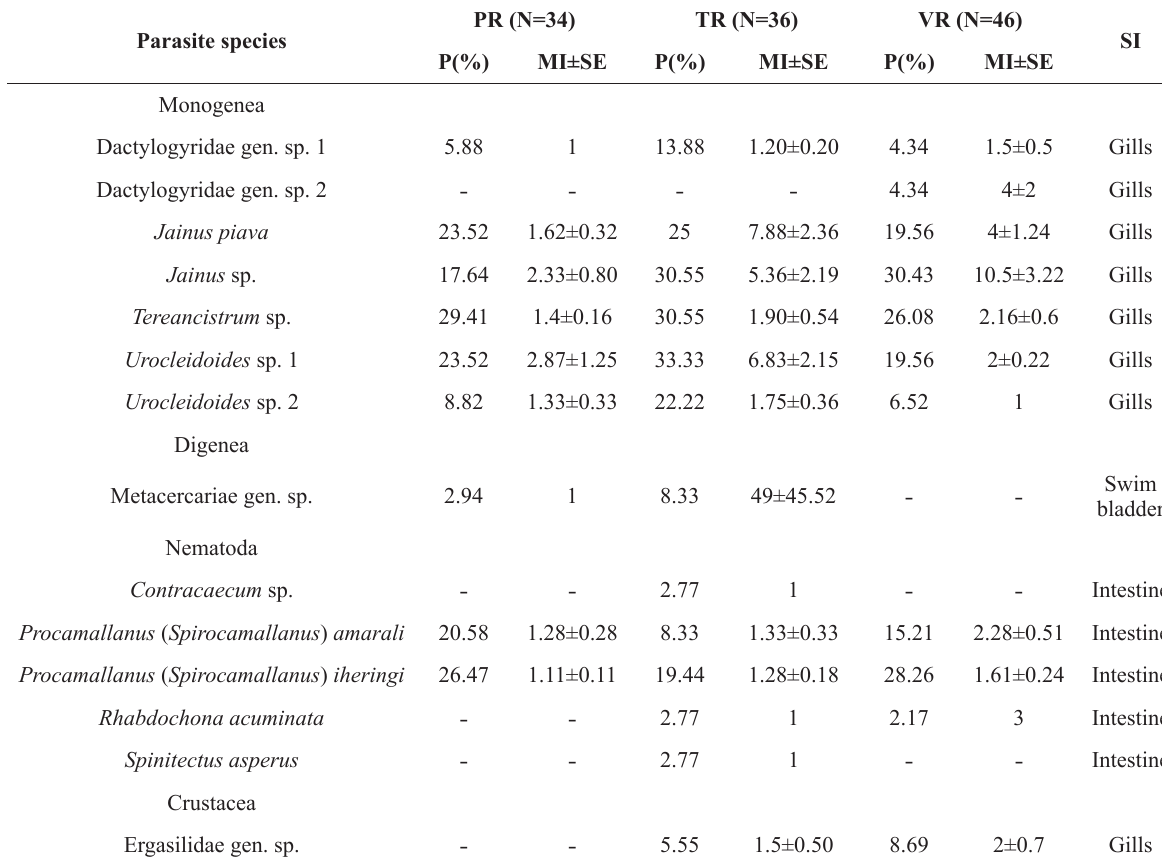
Parasite component community of Leporinus friderici from three upstream tributaries of Jurumirim reservoir, Upper Paranapanema River, southeast, Brazil. Paranapanema River (PR), Taquari River (TR), Veados River (VR), prevalence (P%), mean intensity (MI) ± standard error (SE), and site of infection/infestation (SI). Parasite